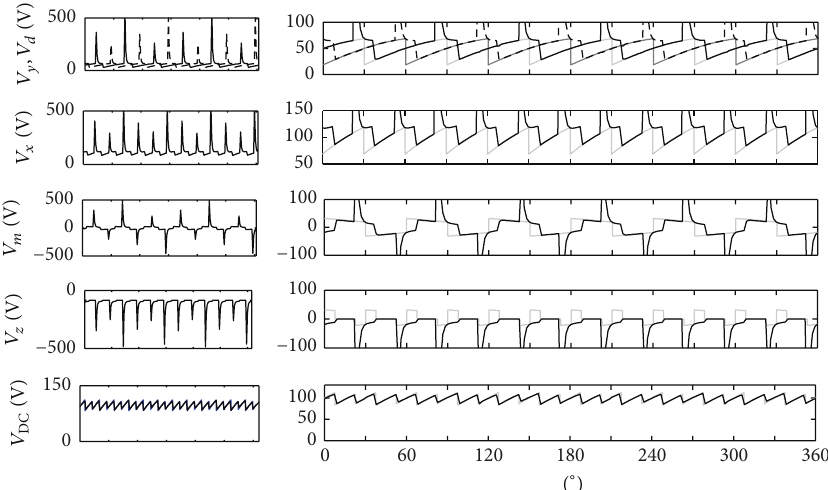
Figure 8: Simulated DC voltage waveforms for 3-level thyristor based MLCR CSC for 𝛼 = − 45 ∘ without RCD snubber.